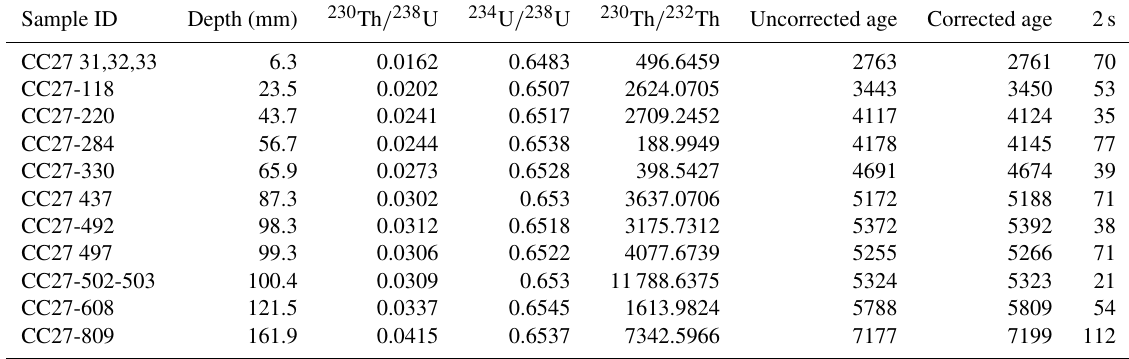
Table 1. U / Th ages for the CC27 stalagmite. Sample ID